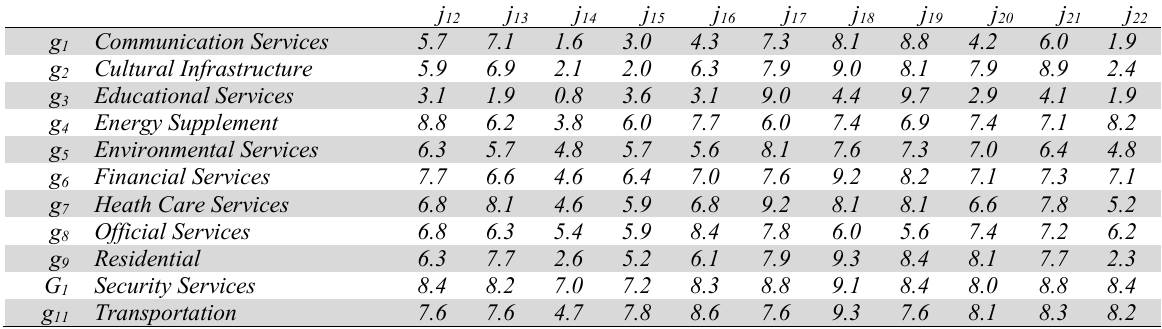
Mean of expert opinion for the impact of infrastructures investment opportunities in in realization of investment opportunities